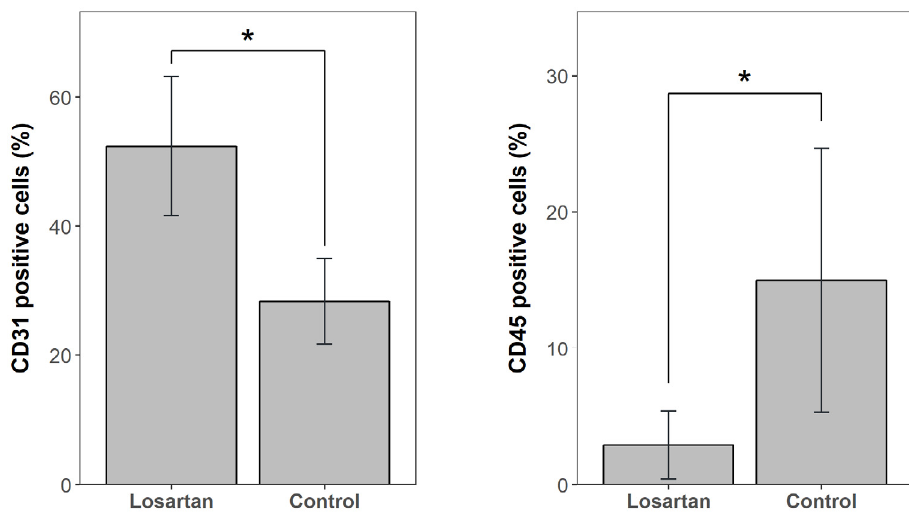
Figure 2. CD31+ cells and CD45+ cells in bone marrow concentrate (BMC) comparing the losartan group to the control group. * p < 0.05.